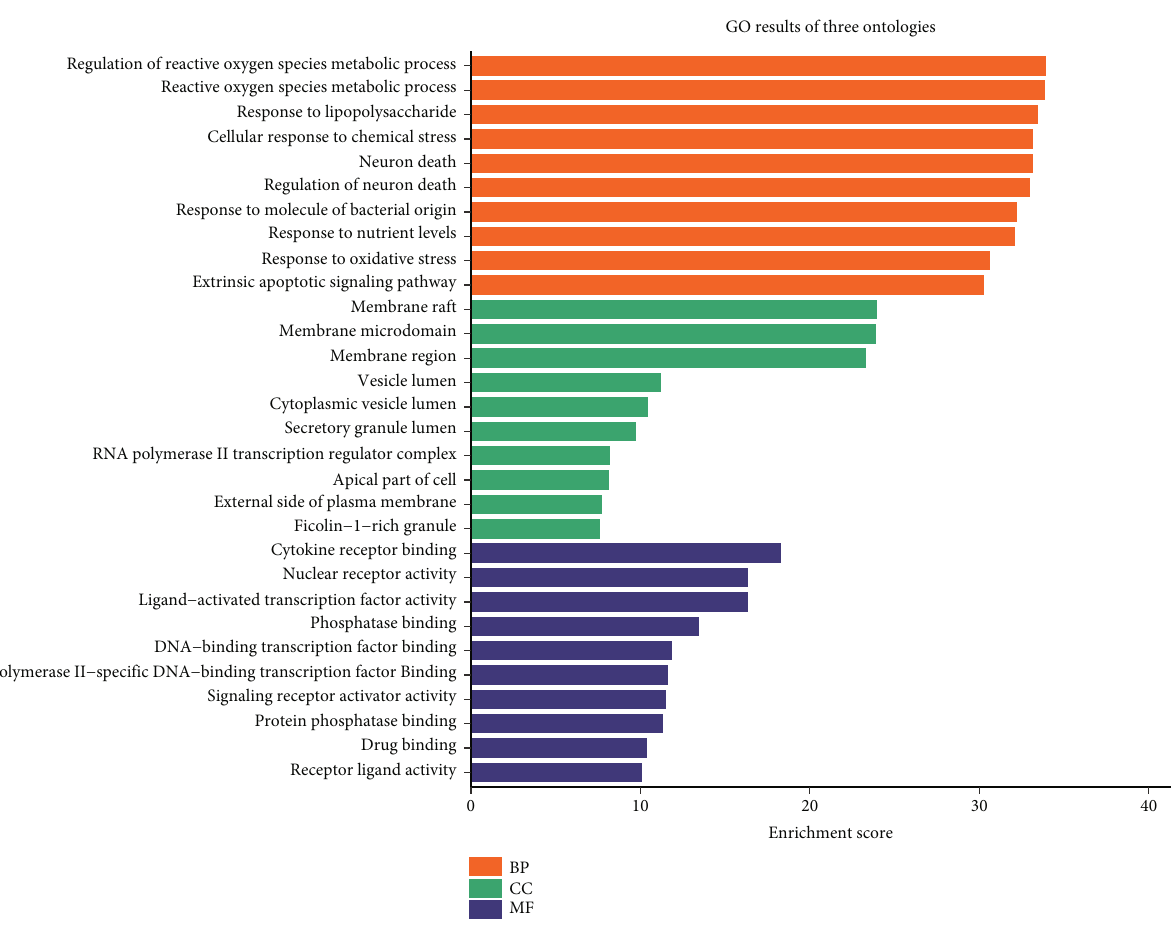
Figure 4: Gene Ontology terms of 227 intersection targets. The top 10 GO functional terms were selected (adj. P < 0 : 01 ). Abbreviations: BP: biological processes; CC: cellular component; MF: molecular